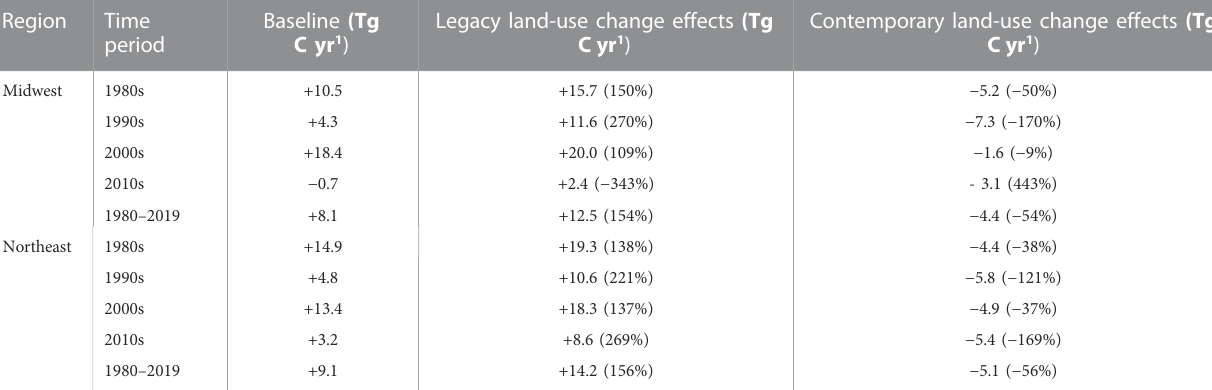
TABLE 4 Relative importance of legacy and contemporary land-use change effects on mean annual net carbon sequestration (Tg C yr -1 ) for forests in the Midwest and Northeast United States estimated by the Terrestrial Ecosystem Model (TEM) for various time periods. + values depict net carbon sequestration; - values indicate anet carbonsource.Values inparentheses arepercentageofnetcarbon sequestration accountedforbylegacyor contemporaryland-usechangeeffects.